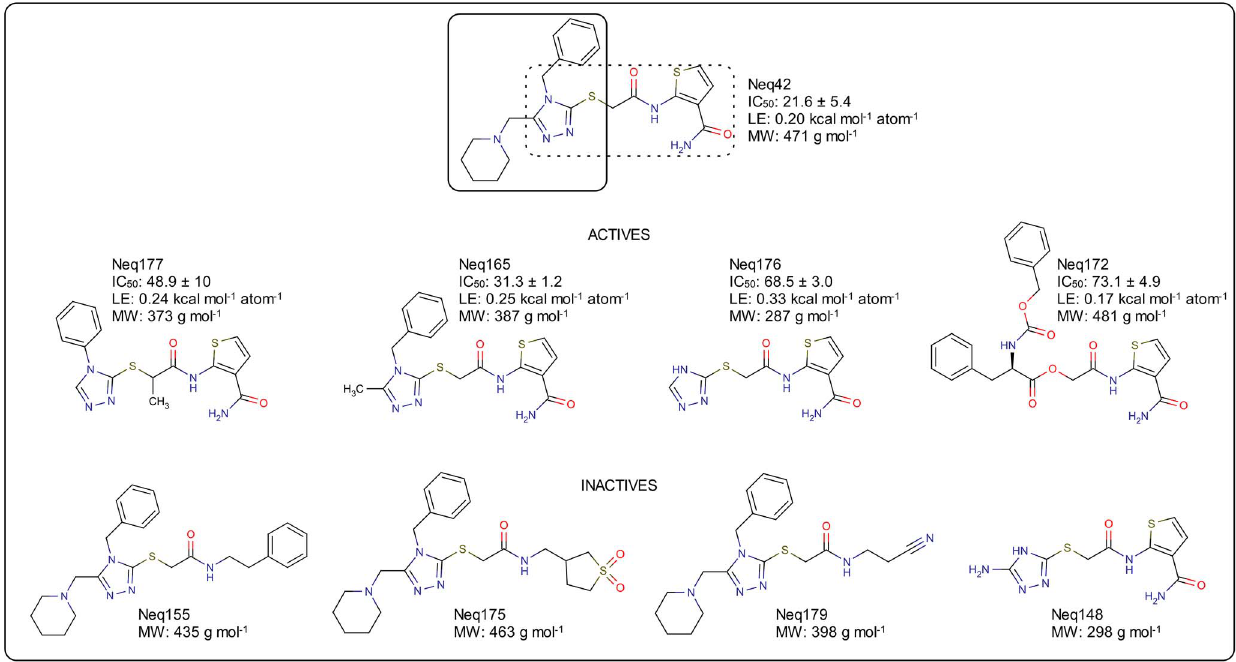
Figure 6. Molecular structure and cruzain inhibition of compound Neq42 analogs selected for SAR investigation. Molecules drawing and figure generated with MarvinSketch software (www.chemaxon.com).